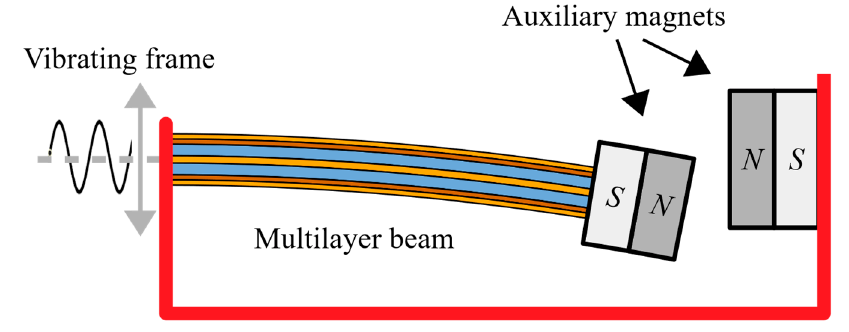
Figure 7. Topology of used auxiliary magnets fixed on the novel multilayer piezoelectric cantilever beam.